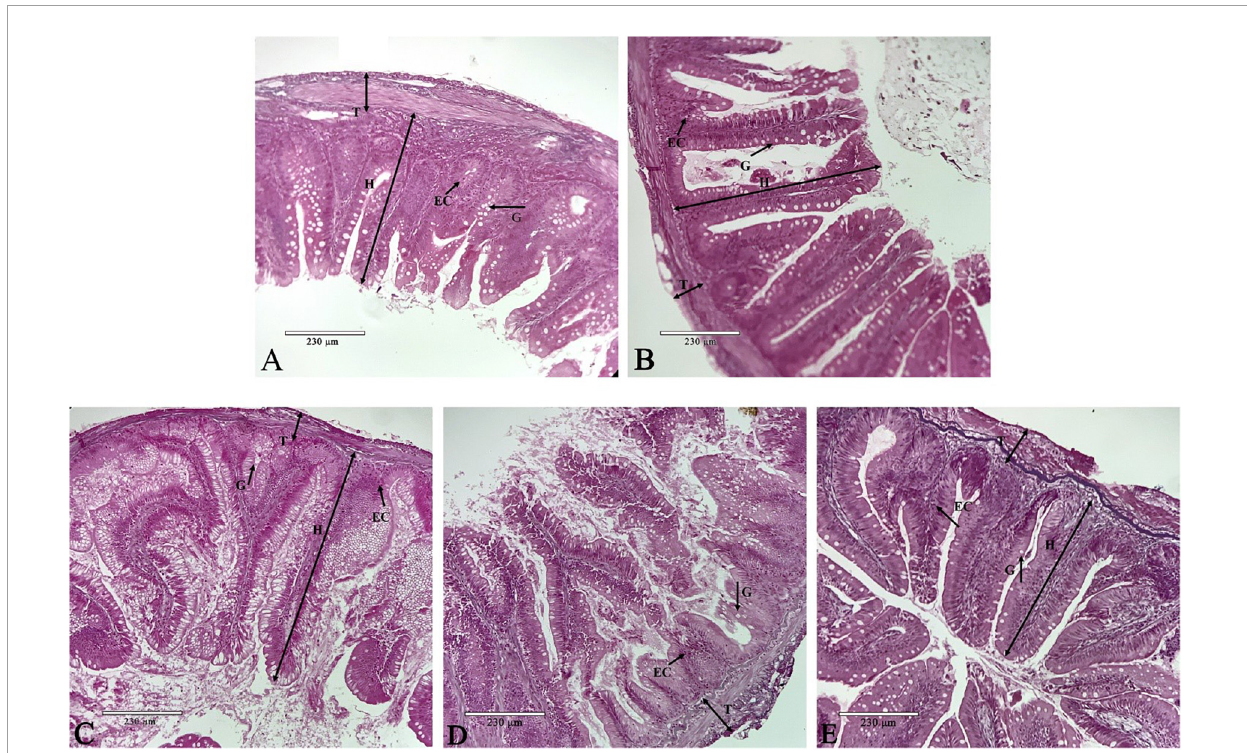
FIGURE3 Intestine histology. Representative histological sections of the intestine from O. mykiss fed the different experimental diets. Scale bar, 230 µ m. Panel (A) was G1 phenylalanine level in intestine tissue 100 × ; Panel (B) was G2 phenylalanine level in intestine tissue 100 × ; Panel (C) was G3 phenylalanine level in intestine tissue 100 × ; Panel (D) was G4 phenylalanine level in intestine tissue 100 × ; and panel (E) was G5 phenylalanine level in intestine tissue 100 × .